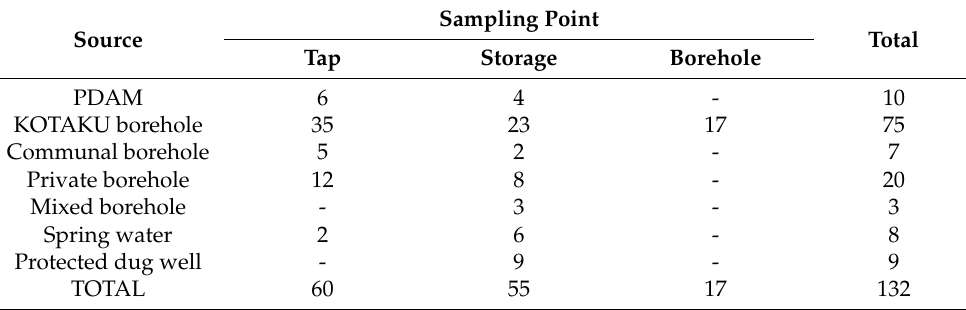
Table 2. Number of samples for water quality analysis at each